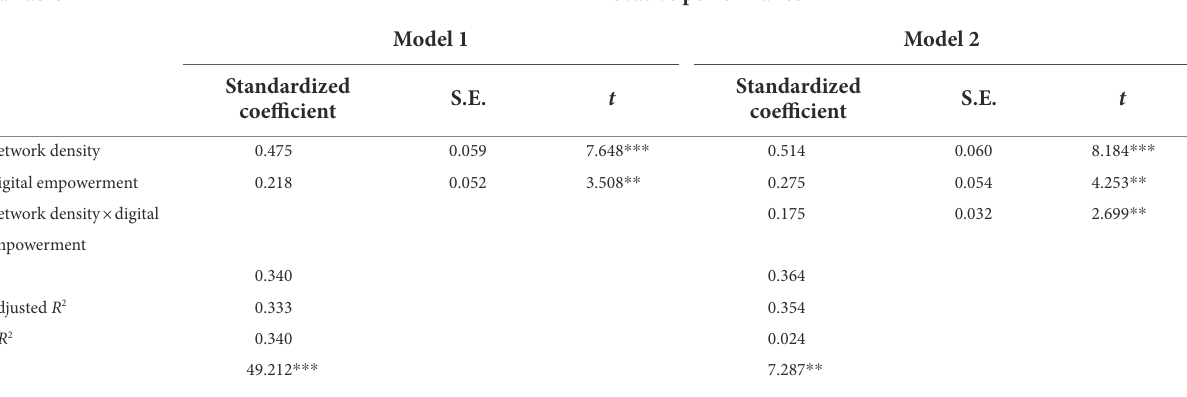
TABLE 12 Test results of the moderating effect of digital empowerment between cluster innovation network density and innovation performance.